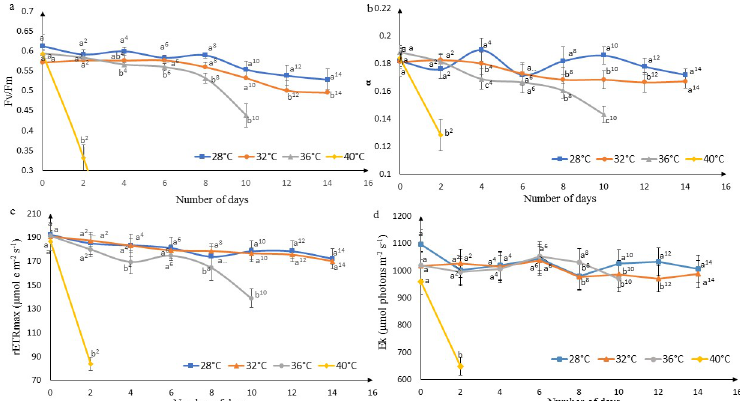
Fig 2. Photosynthetic parameters of K . alvarezii incubated at different temperatures: a) F v /F m , b) α , c) rETR max and d) E k . Data shown are mean values and standard deviations ( n = 5). Different lowercase letters indicate significant differences ( p < 0.05) between different temperature treatments at each time point.